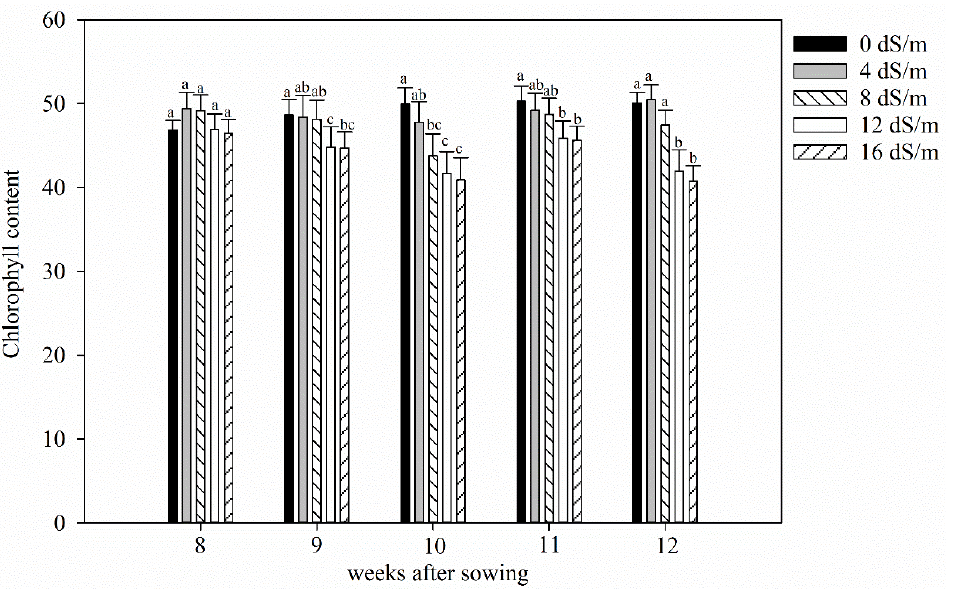
Figure 3. Average chlorophyll content (SPAD value) of alfalfa plants at different stages of growth under five gradient of salt stresses (Electrical conductivities of 0 dS m −1 , 4 dS m −1 , 8 dS m −1 , 12 dS m −1 , 16 dS m −1 ) (salt stress was applied on 4 weeks old plant; error bar represents standard errors of means; means followed by same letter are not significantly different at p < 0.05).